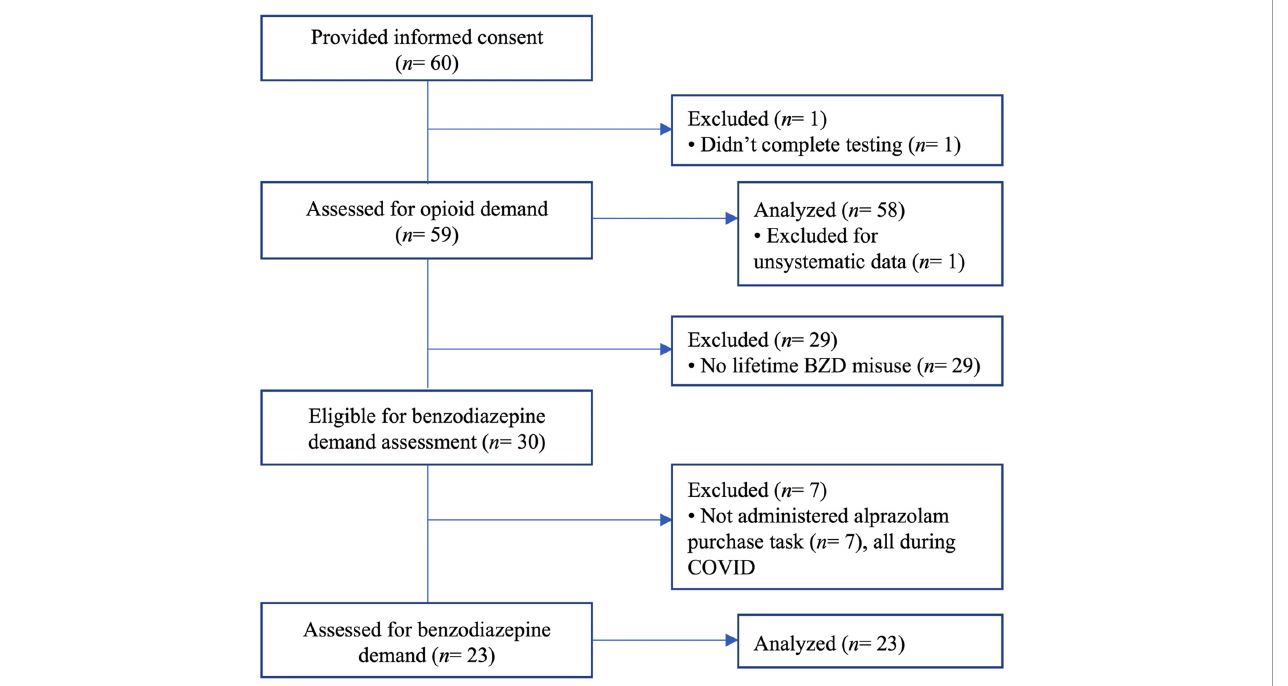
FIGURE1 CONSORT diagram illustrating the flow of participants through the experimental procedures.